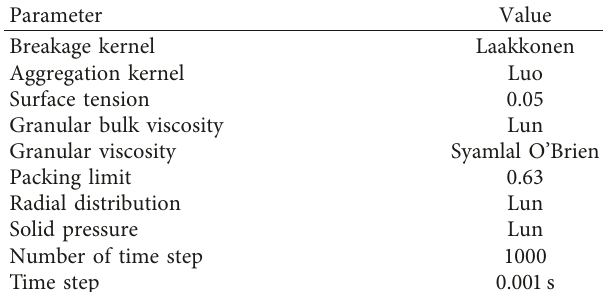
Table 3: Boundary parameter.